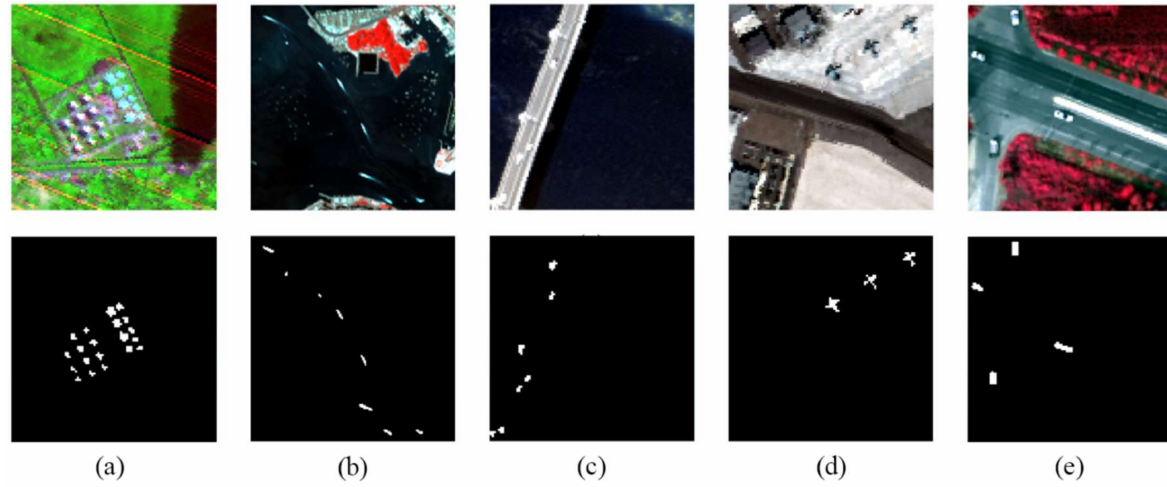
Figure 4. False-color composite images and ground truth maps of the five datasets used: ( a ) Texas Coast Image, ( b ) Belcher Bay Image, ( c ) PaviaC Image, ( d ) San Diego Image, and ( e ) Xiong’an